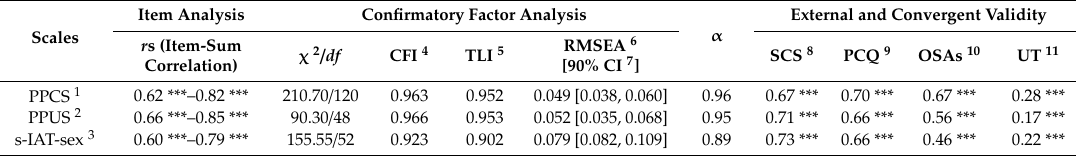
Table 2. Reliability and validity of the three scales.